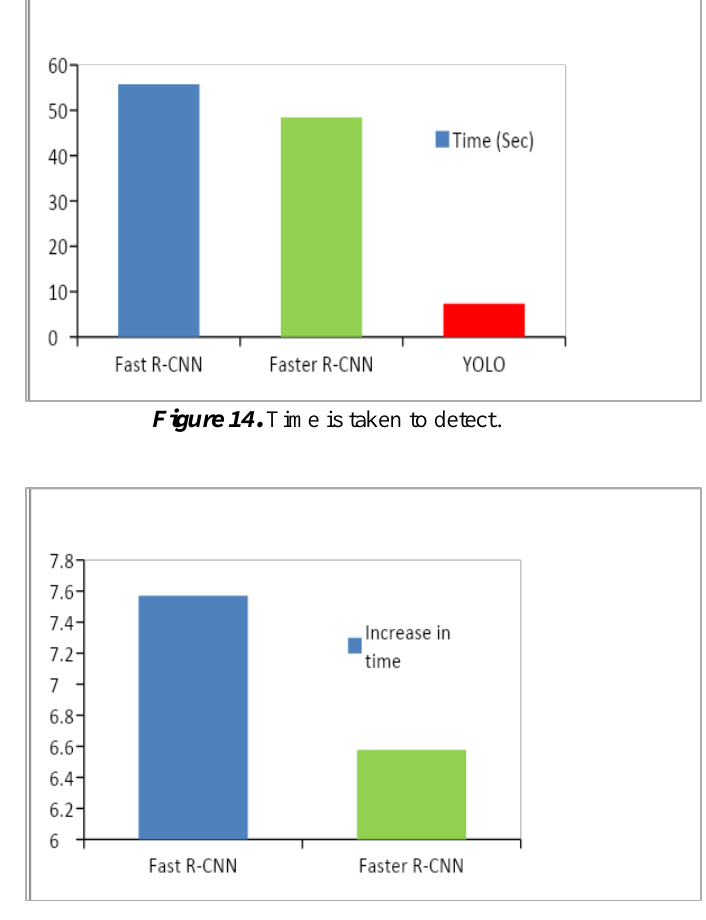
Figure 15. Comparison of